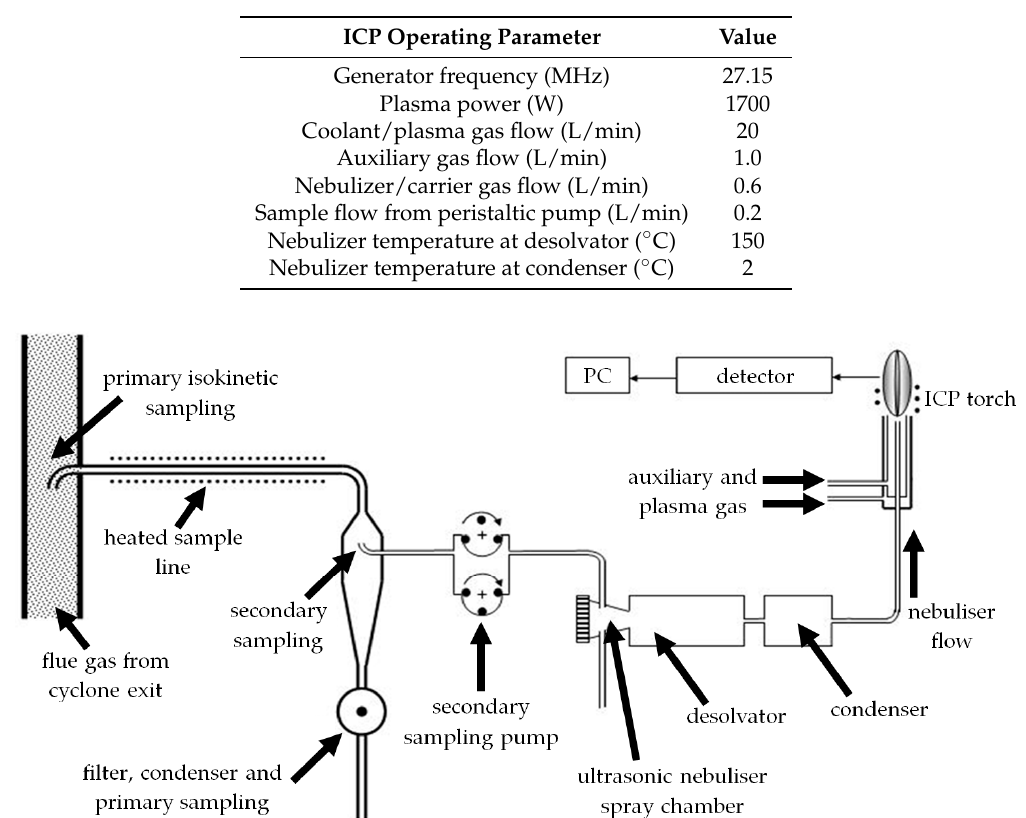
Table 3. Operating parameters used for the Spectro CIROS CCD inductively coupled plasma optical emission spectrometer (ICP-OES) generator and nebulizer.